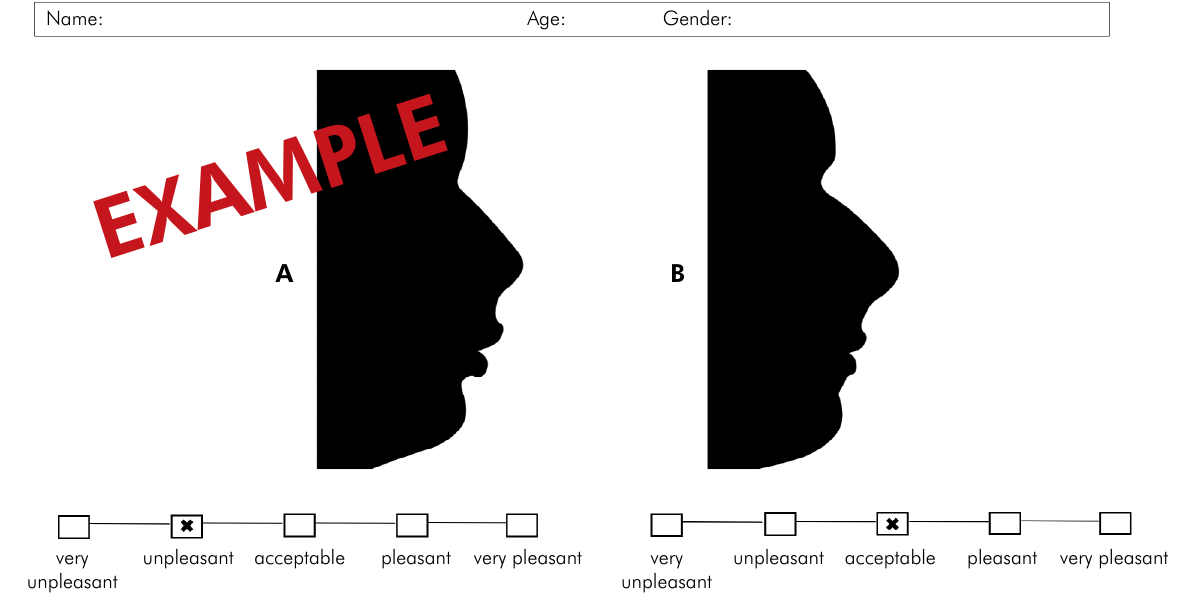
very Figure 2. Example sheet for evaluation of the profile pleasantness using the Likert scale.